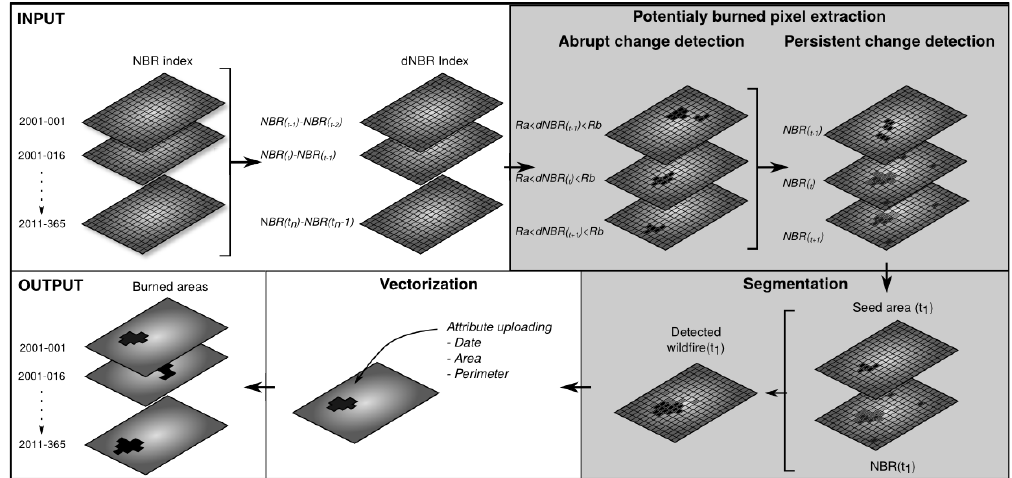
Figure 1: Flowchart of the burned areas detection algorithm indicating input and output data (white panels) and the main processes (Grey panels). The algorithm is applied recursively to each image in the time series, from 2001-001 to